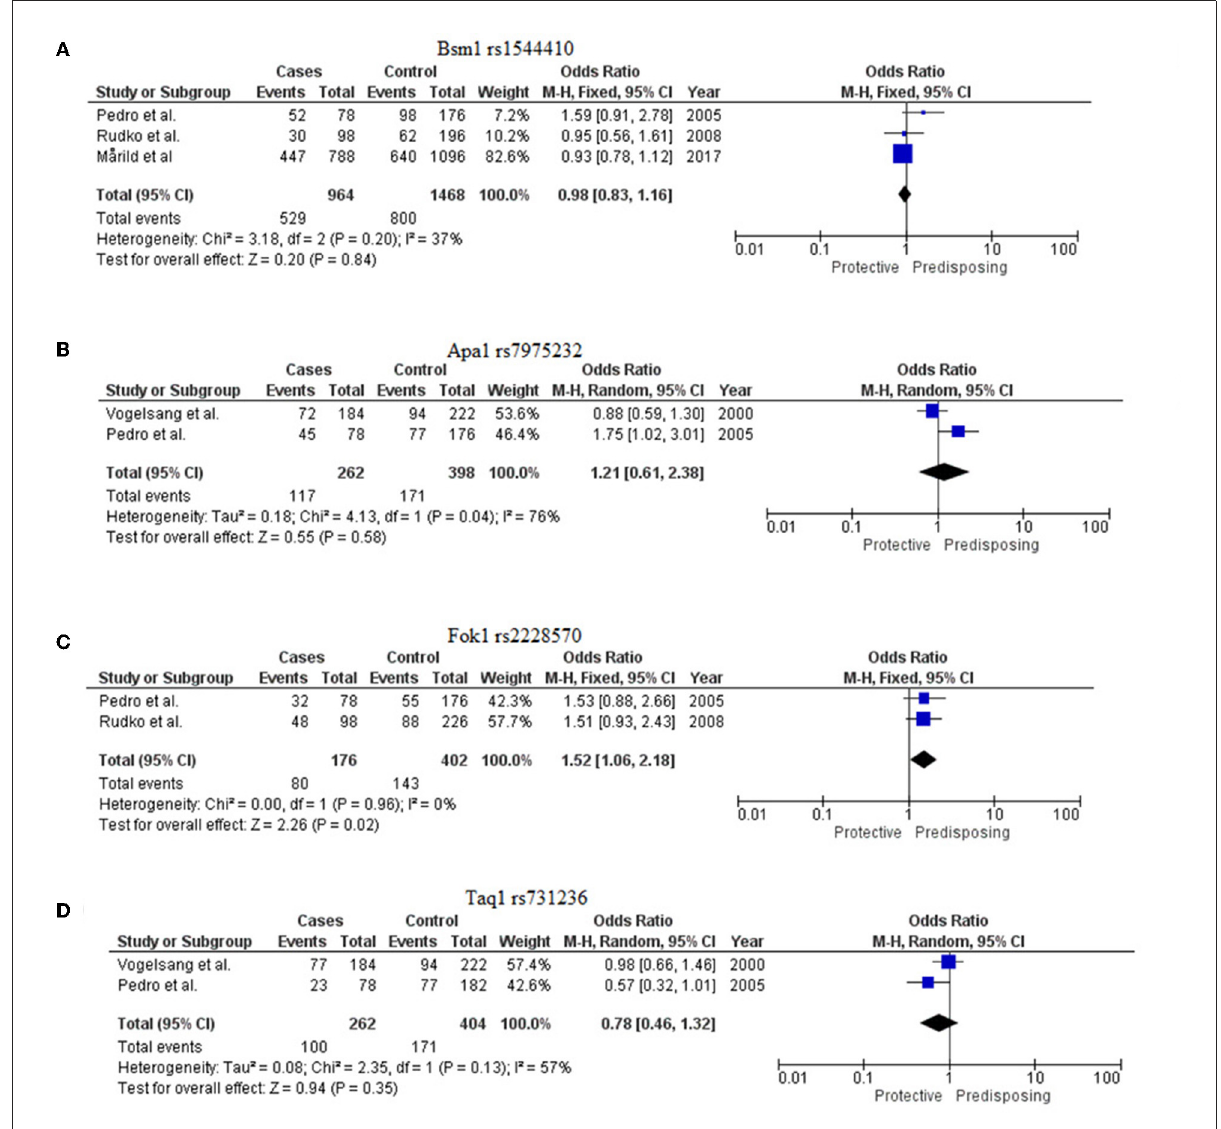
FIGURE3 Forest plots to show meta-analysis of VDR SNPs [ (A) Bsm1 rs 1544410, (B) Apa1 rs 7975232, (C) Fok1 rs 2228570, and (D) Taq1 rs 731236].